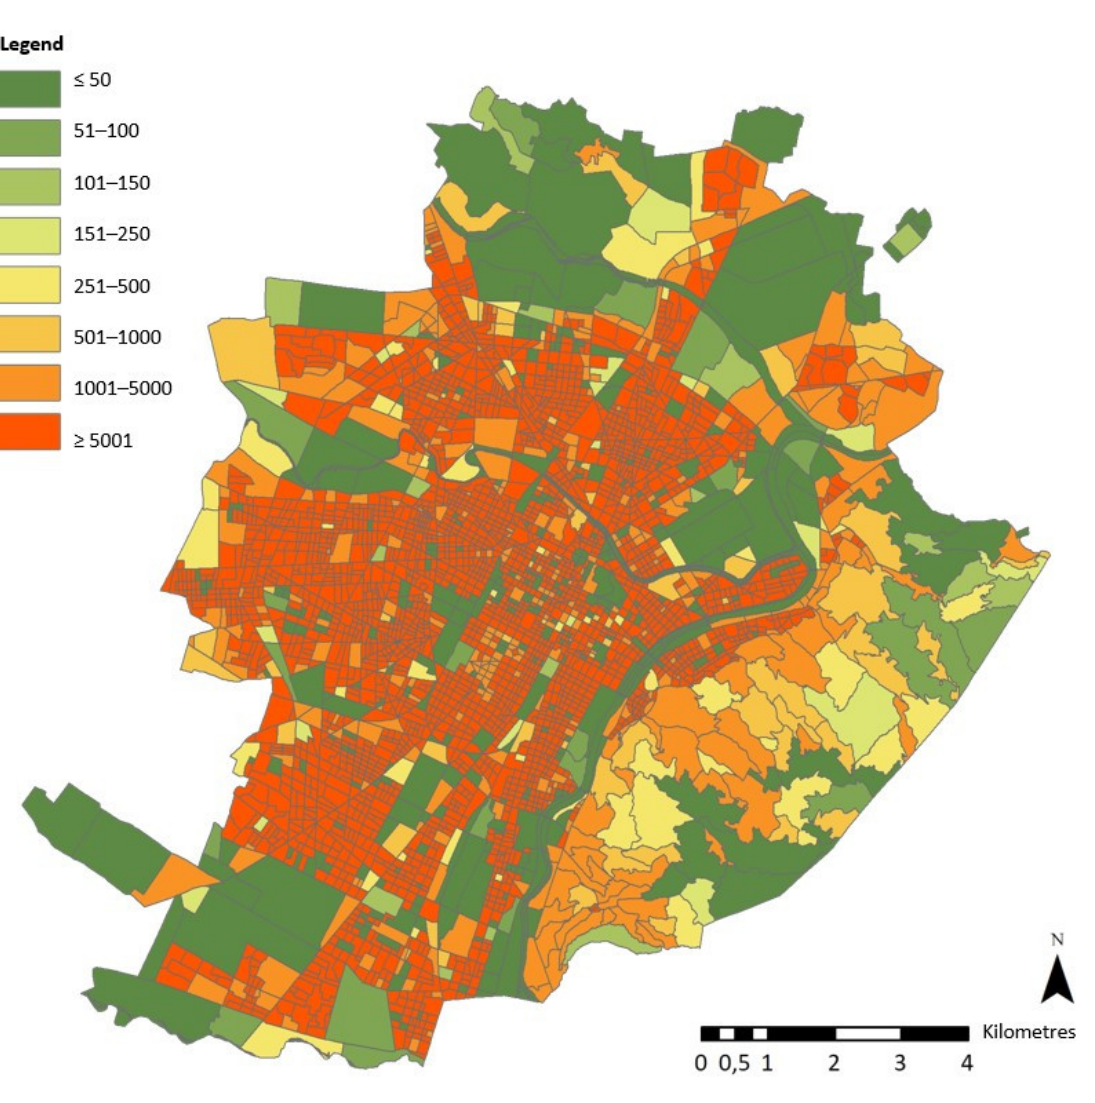
Figure 11. Population density, 2020 [29]. Table 9. Population density of the City of Turin, the Metropolitan City, and the Piedmont Region from 2011 to 2020 [44]. * Pop. = population.